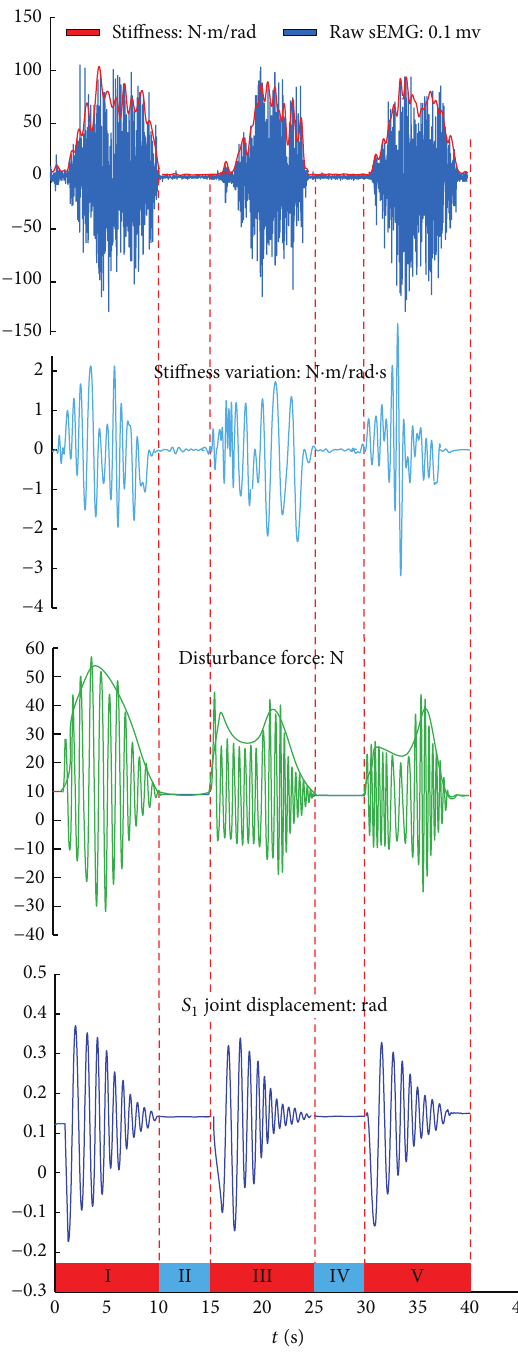
Figure 14: Antidisturbance control under posture maintenance results: human operator cocontracts his arm according to visual feedback from robot arm joint displaced until the disturbance disappears. The test replicates 3 times with approximately 5 seconds of rest intervals from both human subjects.